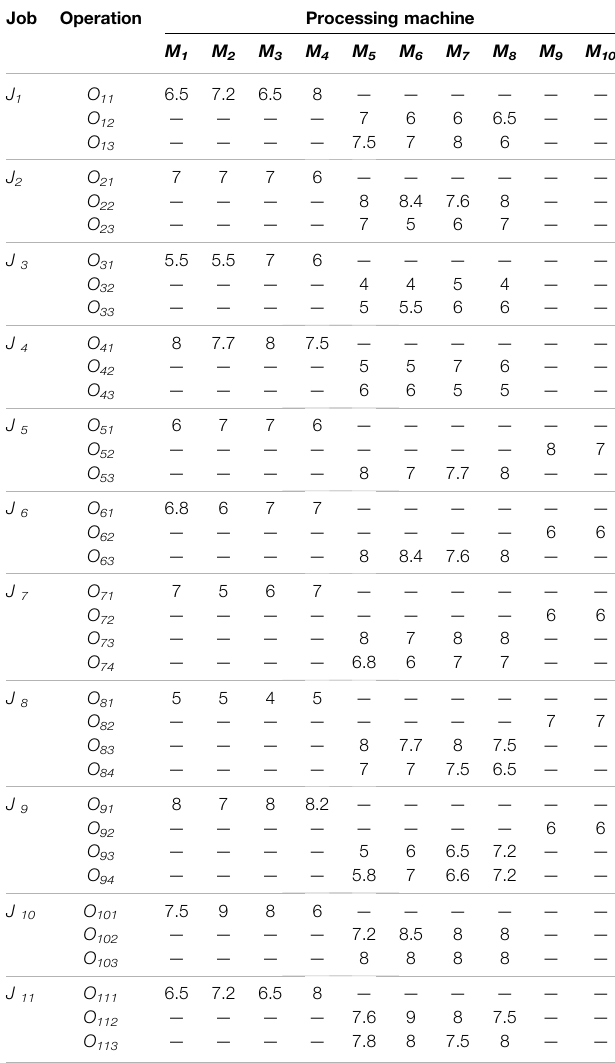
TABLE 4 | Processing time matrix.